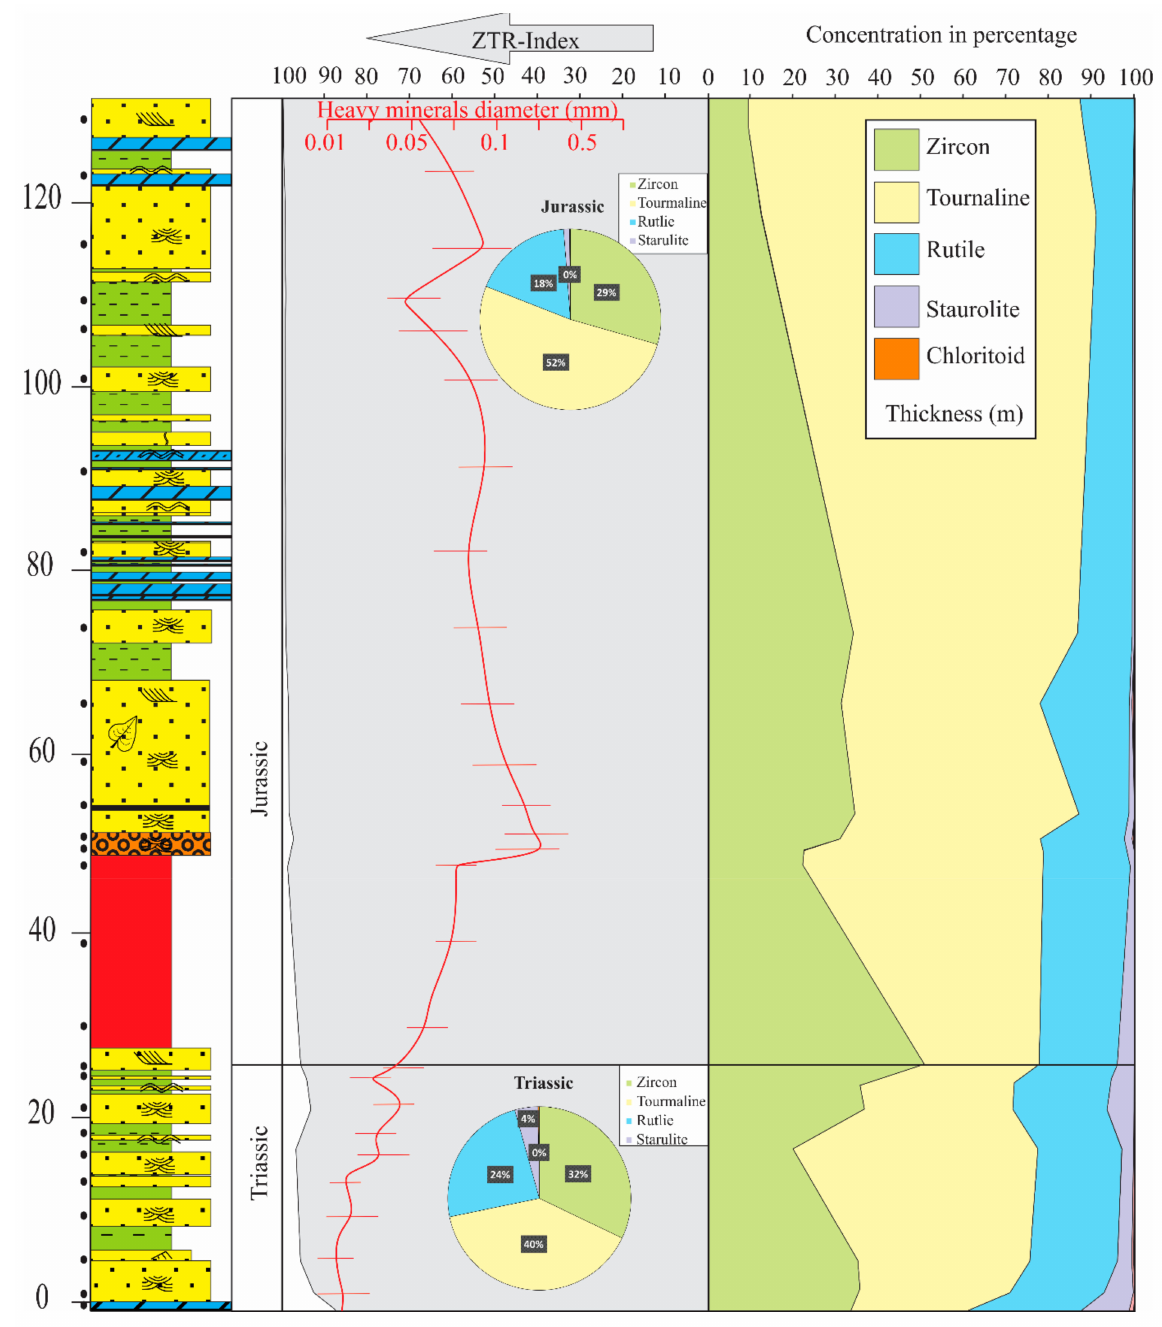
Figure 14. Heavy mineral’s distribution in the Kasanwala section. ZTR-Index [96] is displayed to the left side, indicating an overall very high sediment maturity. A vertical grain size plot is included to have an idea of the grain size variation from Triassic to Jurassic. Pie charts of the point counting for heavy minerals for Triassic and Jurassic sediments are also included to have an idea of the vertical variation from Triassic to